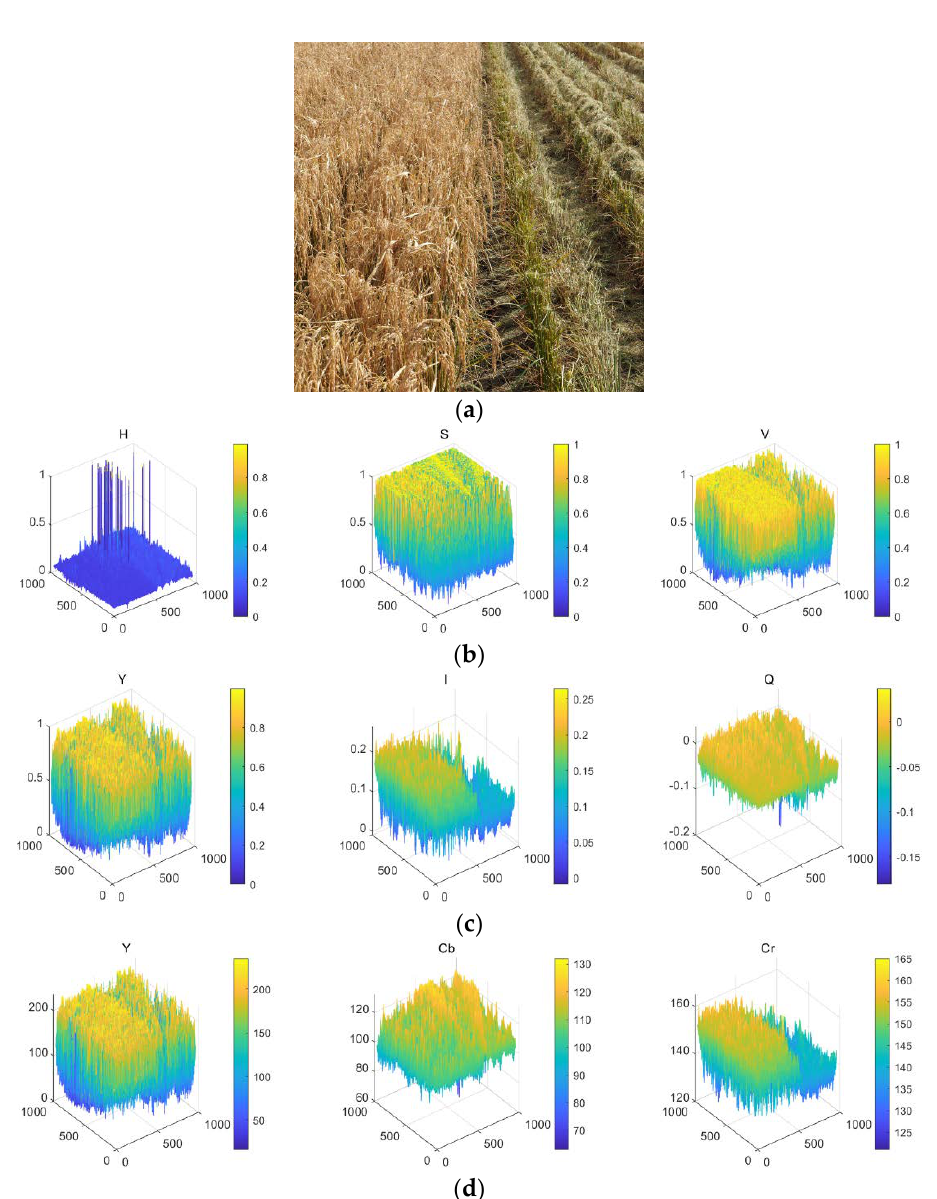
Figure 2. Figure of each color space component model: ( a ) RGB image; ( b ) HSV model; ( c ) NTSC model; ( d ) YCbCr model.